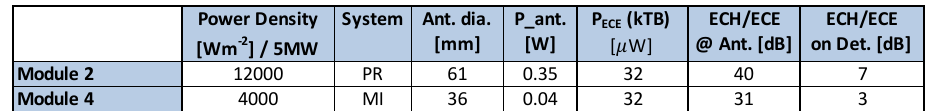
Table 1: Expected power levels. The column P ant gives the maximum ECH power coupled into the antennae: the power density multiplied with the antenna aperture but reduced by the antenna directivity. PR stands for Profile Reflectometer and MI for Michelson. The column P ECE is the ECE power over D-Band, taking a central electron temperature of 5 keV and assuming a parabolic profile. Next the power ratio ECH to ECE in-vessel is calculated. The last column gives this ratio in front of the Michelson: here the stray radiation is strongly reduced due to the transition from oversized horn antenna to single mode